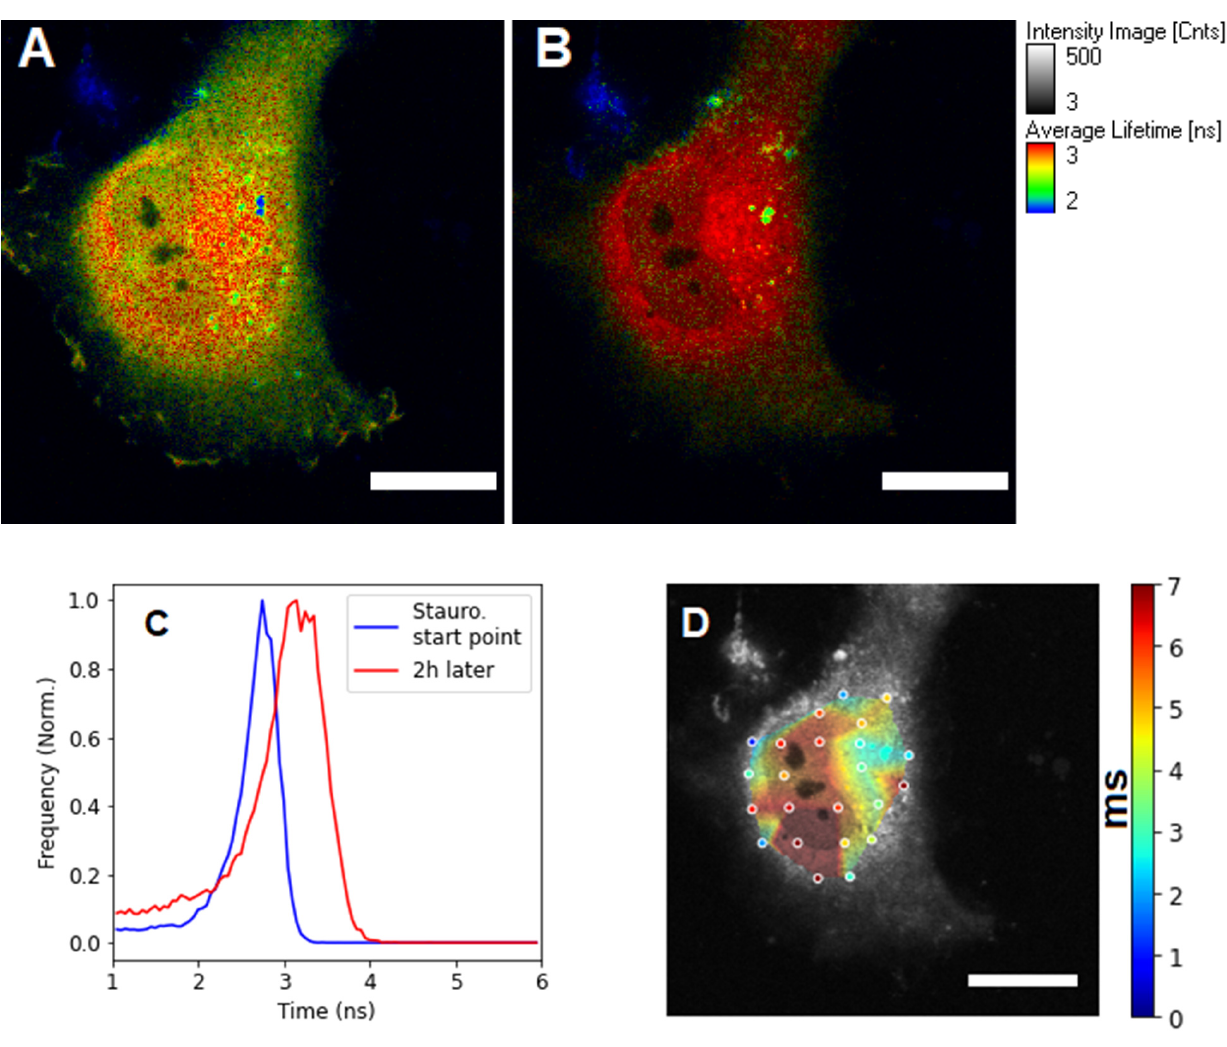
Figure 3. FLIM images of a HeLa cell transfected with a SAASoti-23-KFP sensor, ( A ) right after staurosporine and ( B ) after 2 h of incubation with staurosporine. ( C ) The distribution of the average fluorescence lifetimes is blue before and red after the induction of apoptosis for the whole frame (cell). ( D ) Diffusion time distribution image after 2 h of incubation with staurosporine. Images were acquired using a Microtime 200 confocal system (PicoQuant), excitation at 395/20 nm (red form generation), and 532 nm laser (red form excitation); emission was registered in the red channel. Scale bar = 20 μ m.